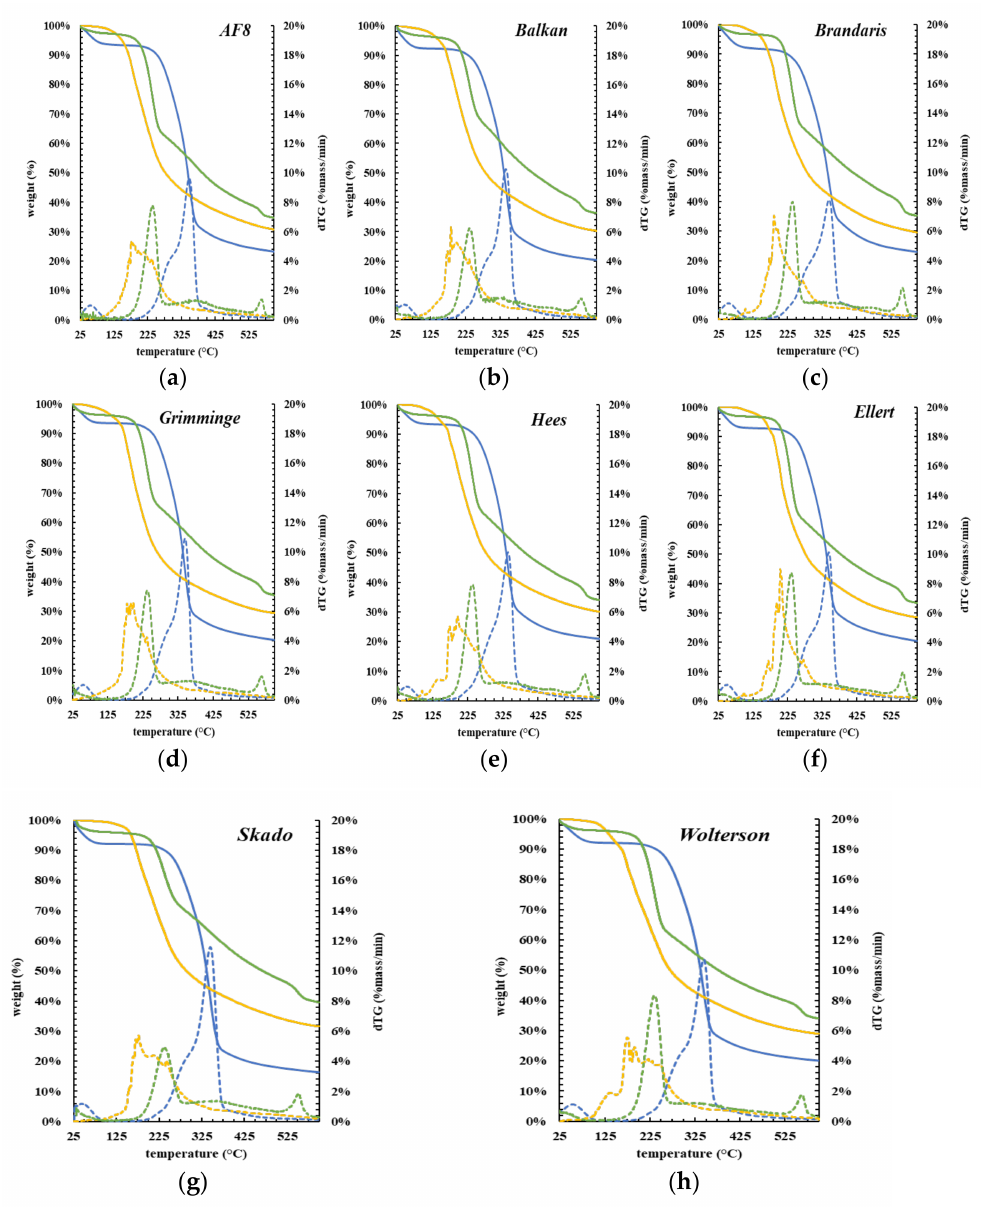
Figure 5. TGA and DTG thermograms of biomass (blue), bio-oil (yellow), and solid residues (green) of all poplar clones: ( a ) AF8 ; ( b ) Balkan ; ( c ) Brandaris ; ( d ) Grimminge ; ( e ) Hees ; ( f ) Ellert ; ( g ) Skado ; ( h ) Wolterson . The dashed line is gTG and the solid line is